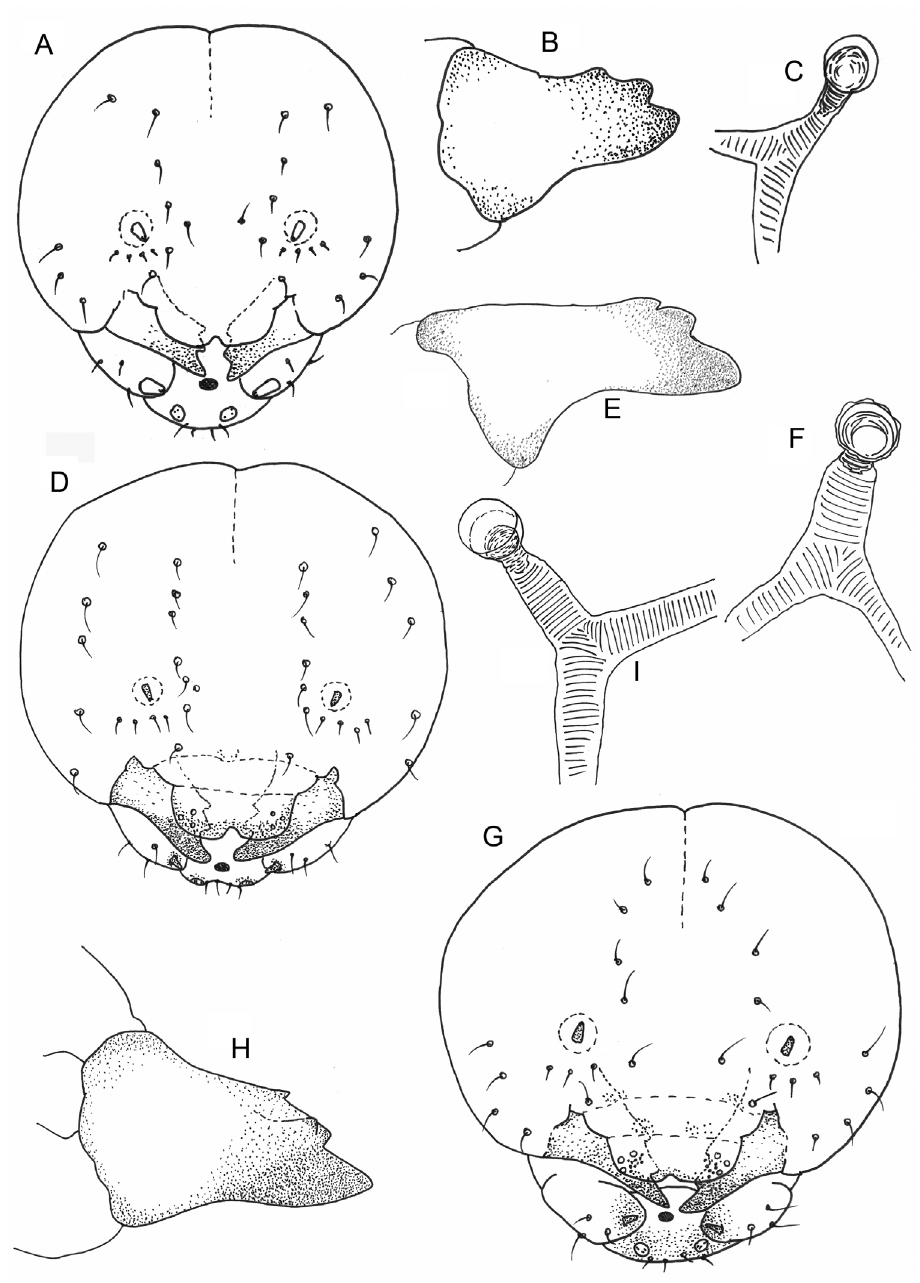
Figure 5. Body parts of larvae of Gasteruption . Gasteruption assectator . A head, frontal view B mandible, frontal view C spiracle. Gasteruption nigrescens D head, frontal view E mandible, frontal view F spiracle. Gasteruption phragmiticola G head, frontal view H mandible, frontal view I